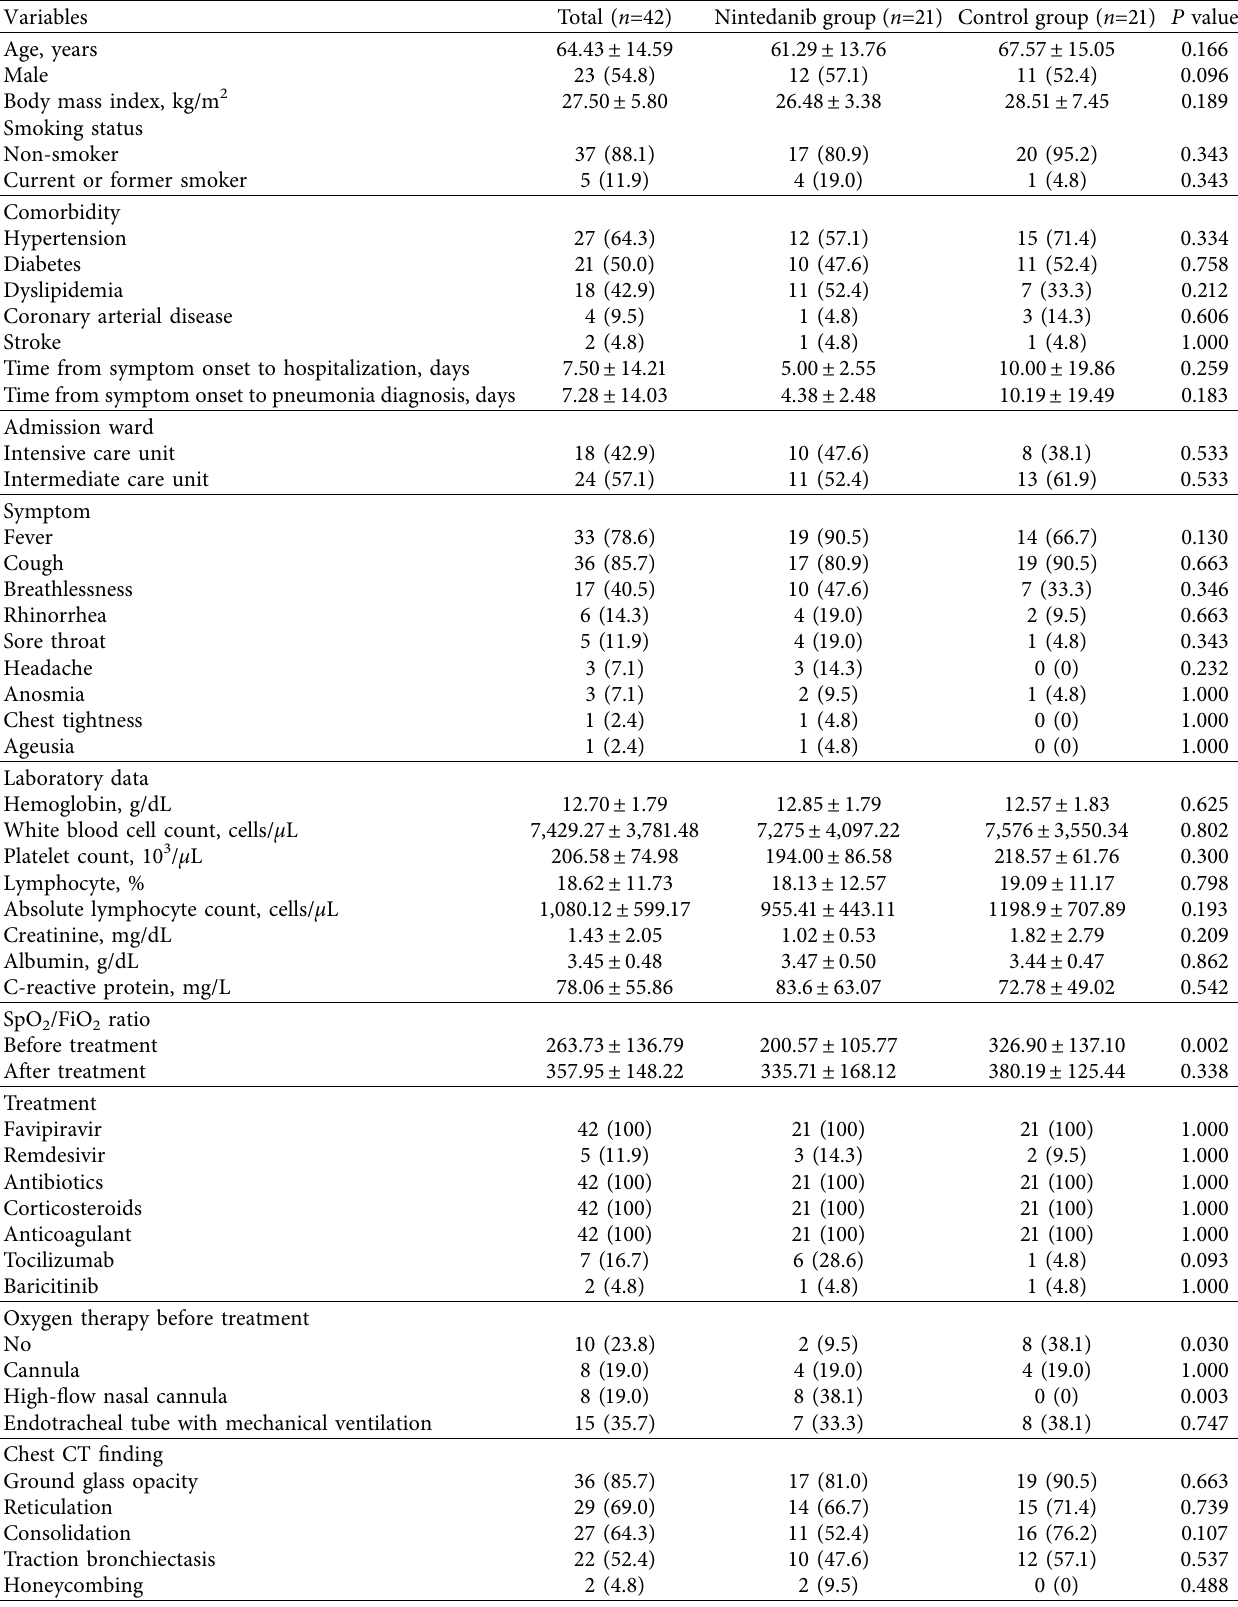
Table 1: Baseline characteristics of hospitalized patients with COVID-19